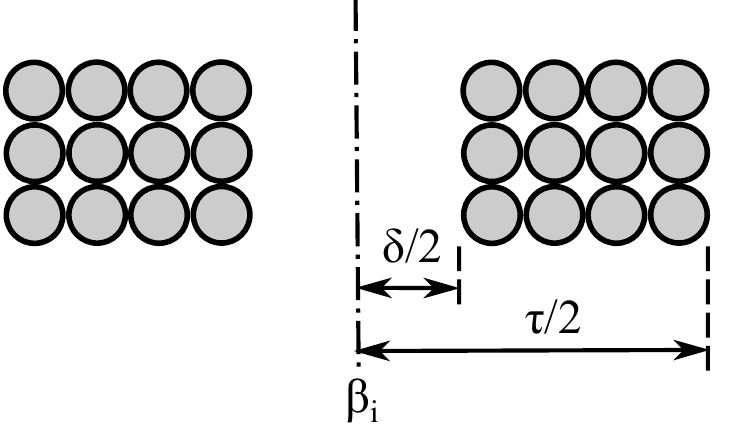
Figure 9. Sectional view of coil i